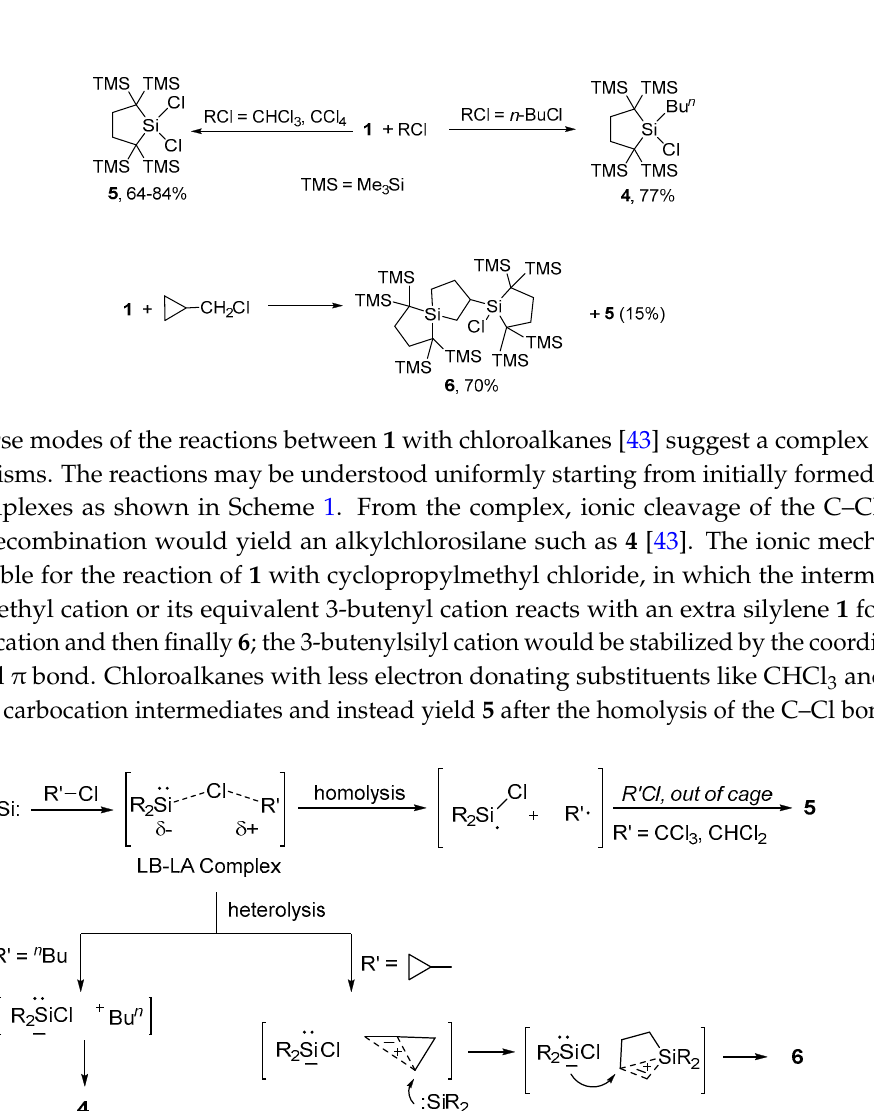
Figure 3. ORTEP drawing of compound 3c . (Hydrogen atoms are omitted for clarity. Thermal ellipsoids are shown at the 30% probability level.) Selected bond lengths (Å) and angles (°): Si(1)–C(1) 1.8789(17), Si(1)–C(4) 1.8850(16), Si(1)–C(17) 1.9364(19), Si(1)–Cl(1) 2.1029(7), C(17)–O(1) 1.217(2); C(1)–Si(1)–C(4) 102.20(7), C(17)–Si(1)–Cl(1) 7.03(6), O(1)–C(17)–C(18) 18.54(16), O(1)–C(17)–Si(1) 15.19(14), C(18)–C(17)–Si(1) 126.03(13).